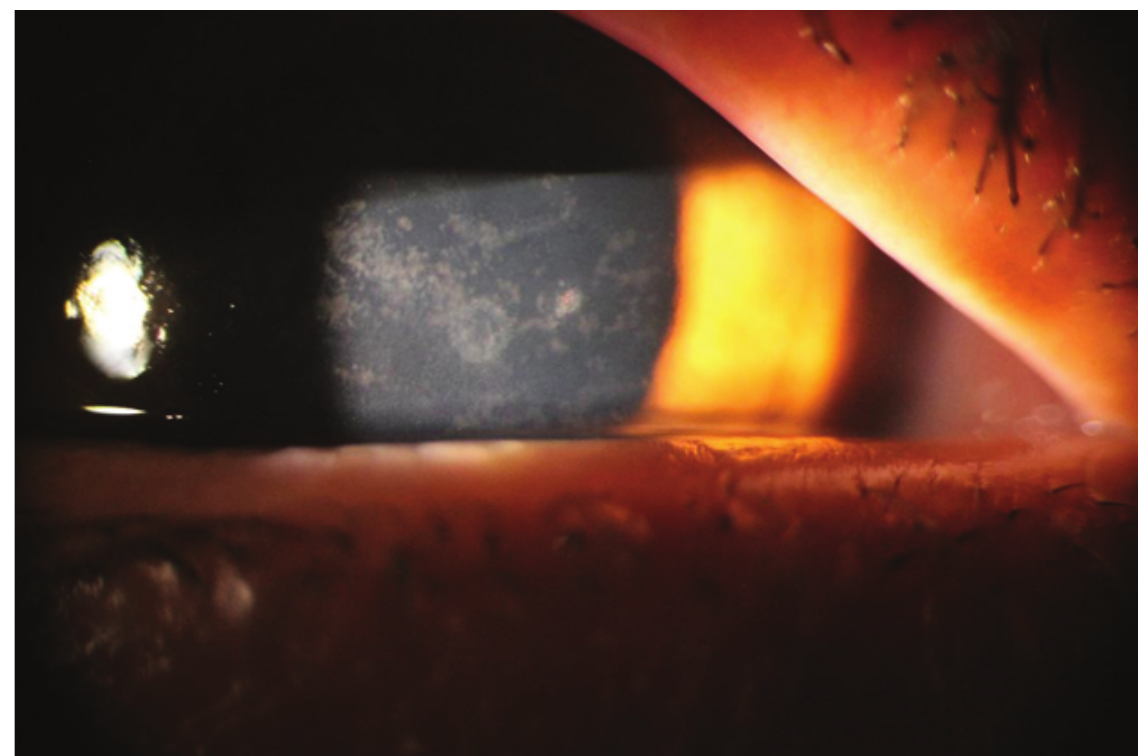
Figure 1. Multiple small epithelial defects secondary to several high-velocity projectiles. Note the central endothelial ring opacity.